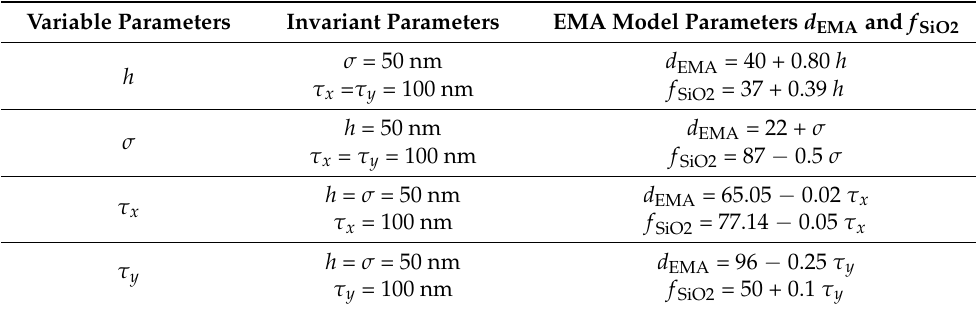
Table 3. The relationship between the topographic characteristic parameters ( h , σ , τ x and τ y ) of the random rough surface and the parameters of the EMA